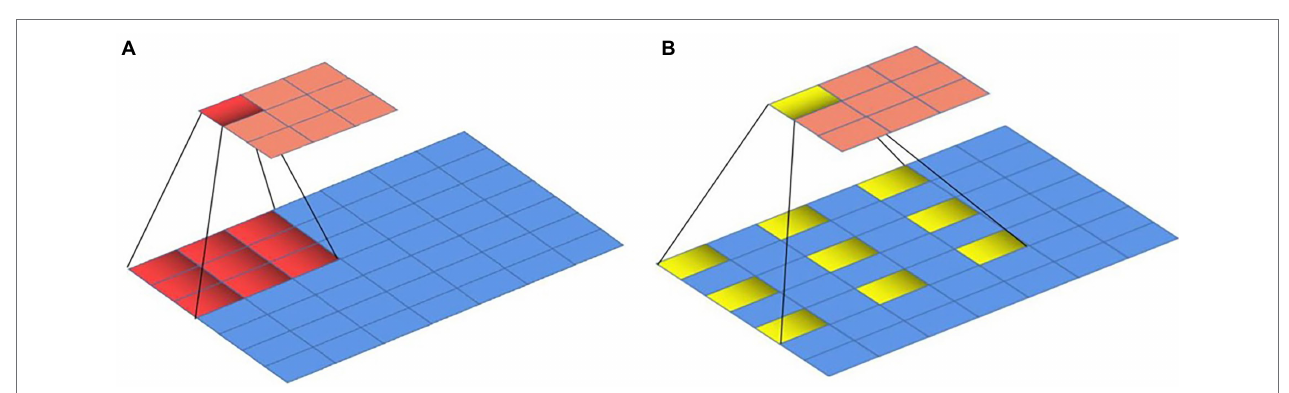
FIGURE 5 | Convolution execution process. (A) Standard convolution work process, (B) The dilated convolution work